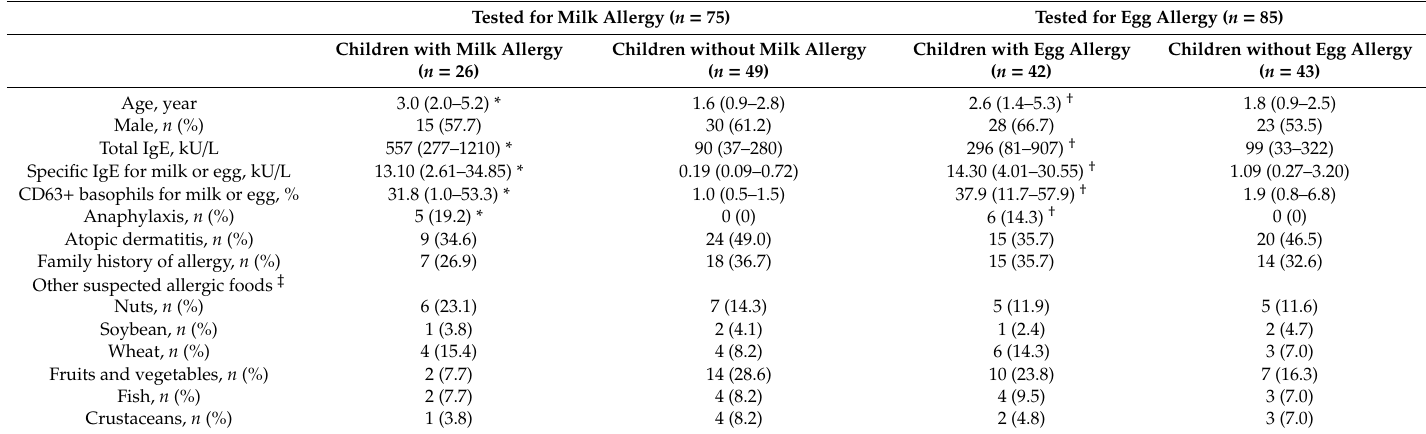
Table 1. Subjects’ characteristics.